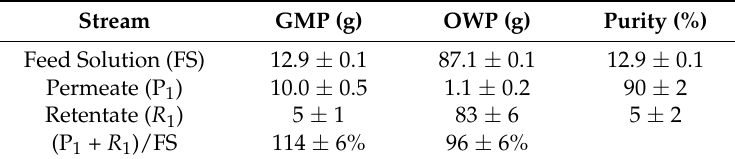
Table 3. Mass balances for GMP and the OWP, and purity of GMP for the one-stage flow configuration evaluated in this work.